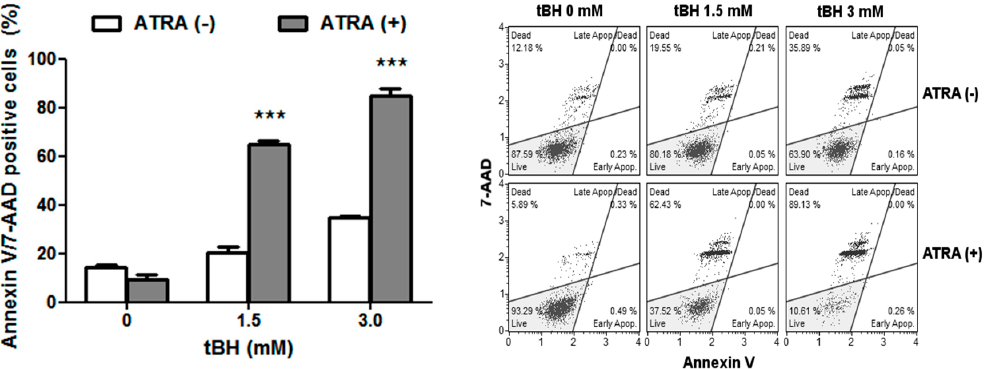
Figure 2. Cell death of ATRA-treated and control ARPE-19 cells exposed to tert -butyl hydroperoxide (tBH) for 4 h at 37 °C as assessed by flow cytometry with Annexin V/7-AAD staining. Results are presented as mean ± SEM, n = 8, *** p < 0.001. Representative fluorescence activated cell sorting (FACS) analysis of Annexin V labeling profiles are presented.